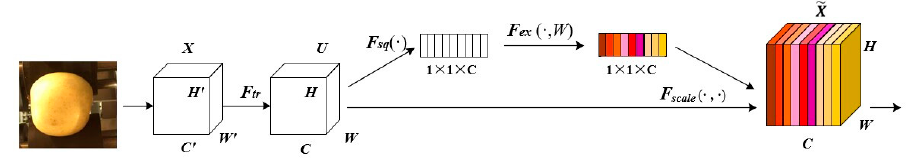
Figure 11. Squeeze and excitation.